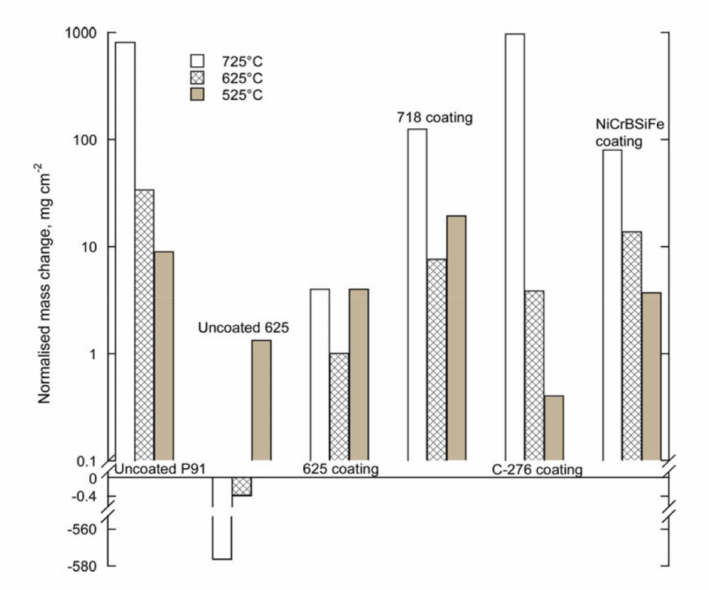
Figure 6. Mass change of IN625, C276, and NiCrBSiFe after corrosion tests